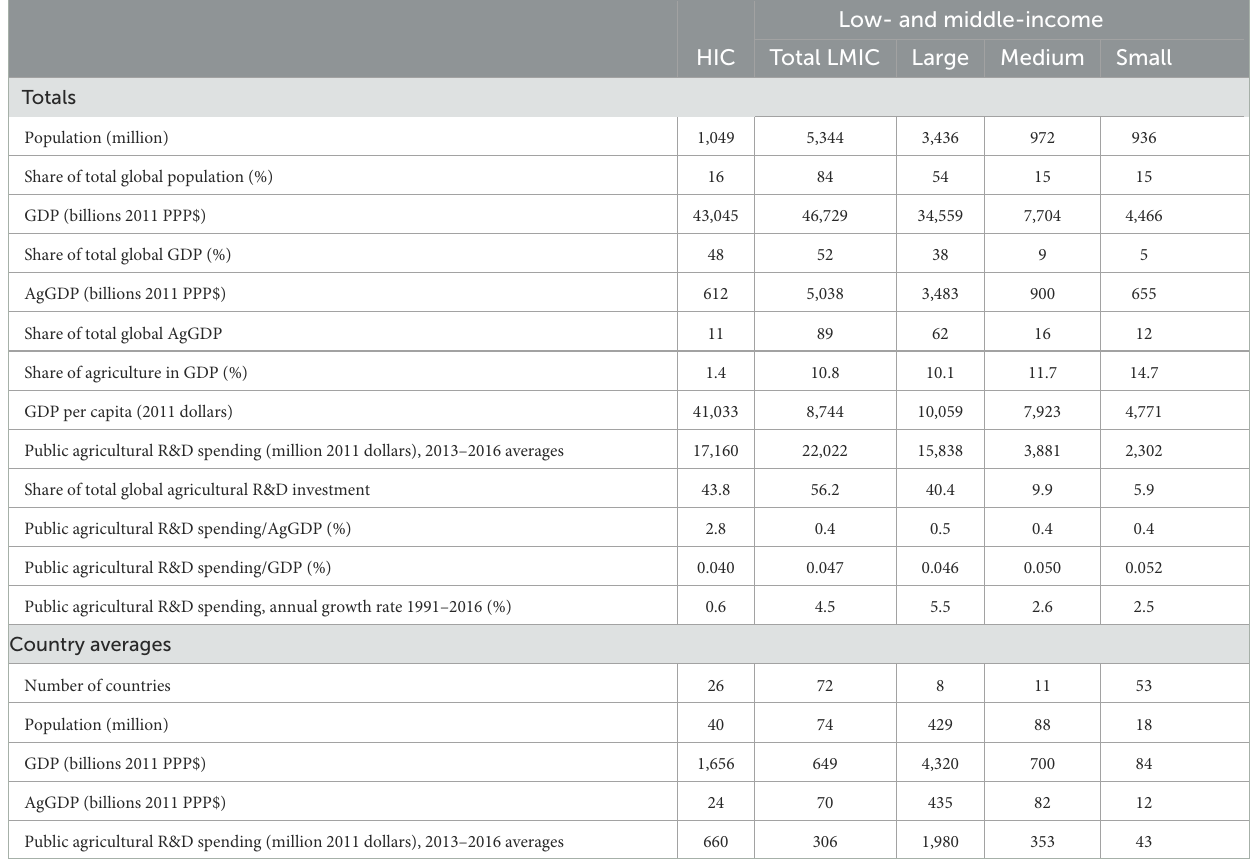
TABLE 1 Macroeconomic and agricultural R&D investment indicators for HICs and LMICs grouped by the size of the research system.